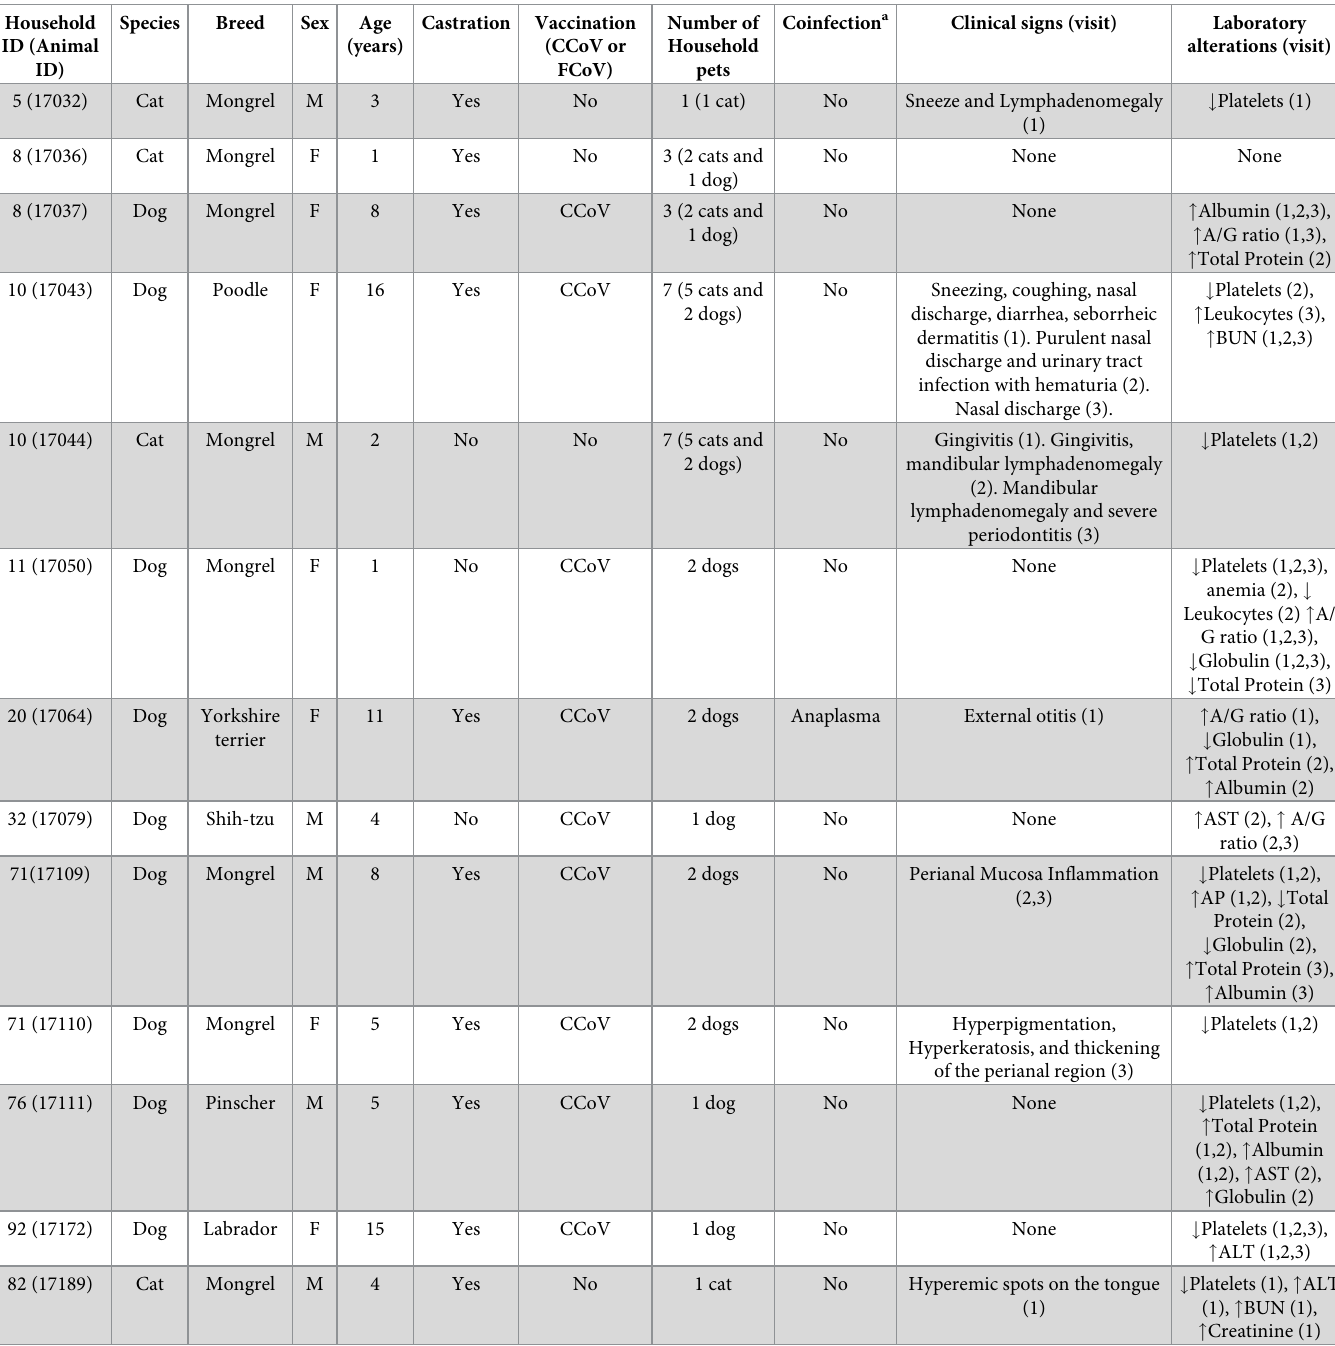
Table 3. Clinical-epidemiological characteristics and laboratory alterations of 13 animals infected with or seropositive for SARS-CoV-2 between May 2 nd , 2020 and October 7 th , 2020 (metropolitan region of the state of Rio de Janeiro, Brazil). Household ID